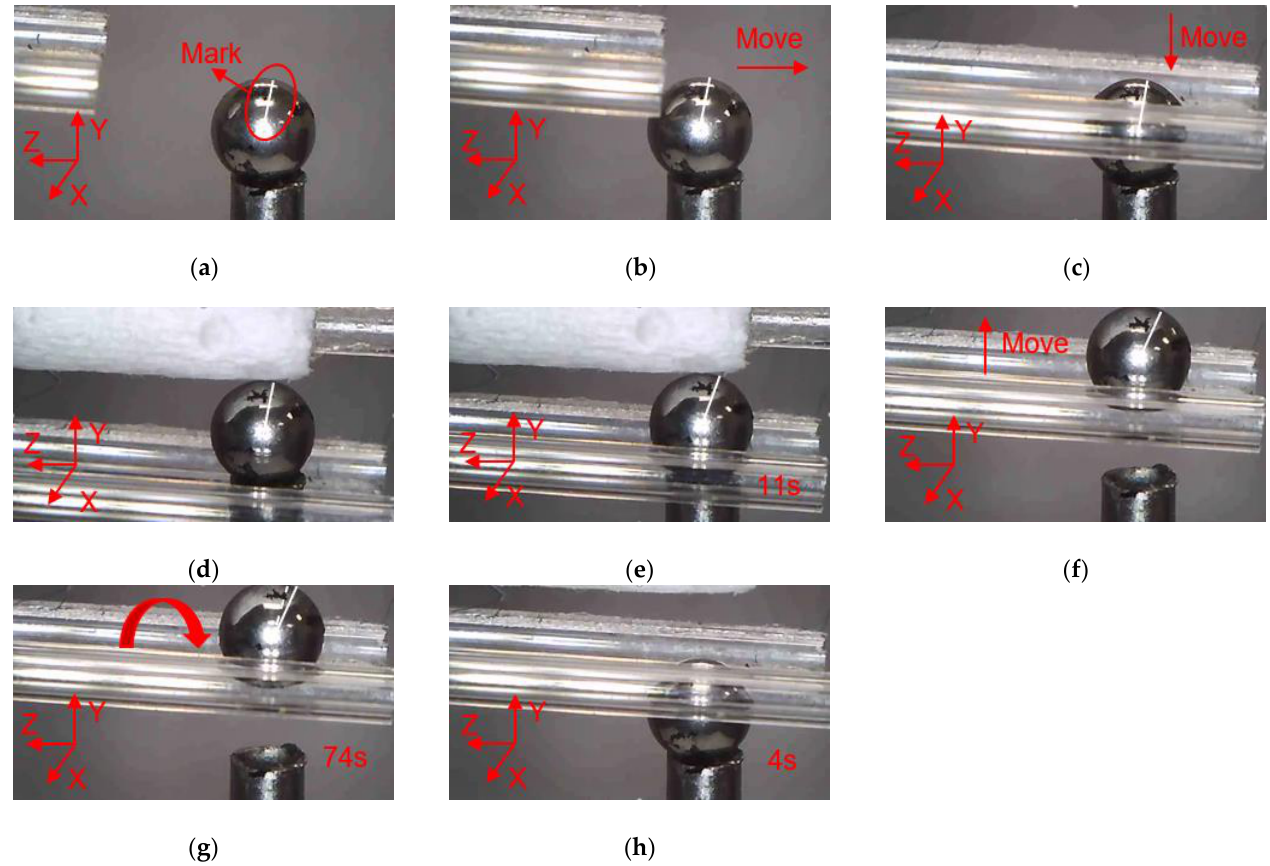
Figure 15. Manipulation of a micro ball: ( a ) Initial state; ( b ) Microgripper is moved to approach the micro ball; ( c ) The microgripper is moved downward to approach the micro ball; ( d ) The microgripper is reached to the clamping position; ( e ) The micro ball is clamped; ( f ) The micro ball is move upward; ( g ) The micro ball is rotated about axis X; ( h ) The micro ball is released.